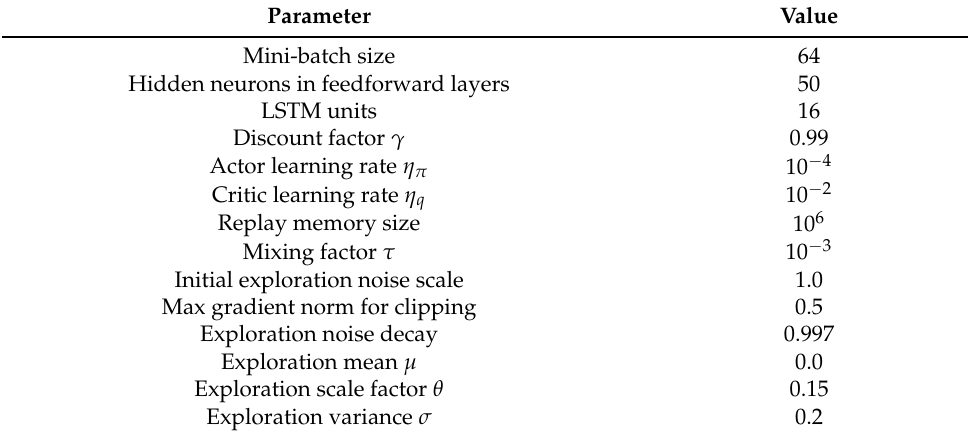
Table 1. Network